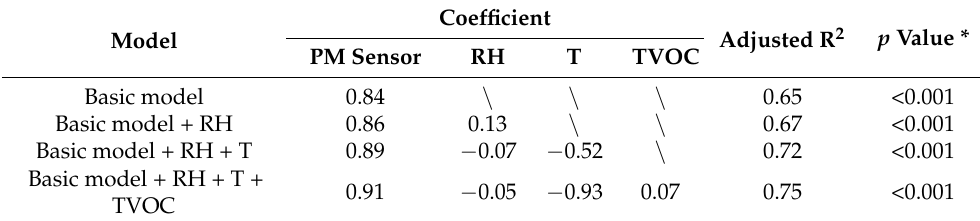
Table 2. Model results of different correction factors for PM sensor 1.